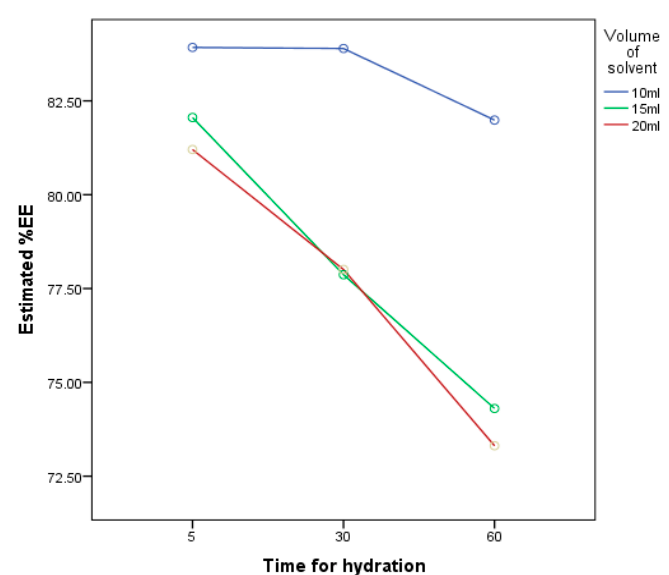
Figure 5. A graph representing the relationship between the results of the three-level factorial design that has been studied for optimization of hydration conditions; the factors were: The volume of the hydrating medium and the time for hydration, and the response is their effect on the % of the entrapment efficiency.